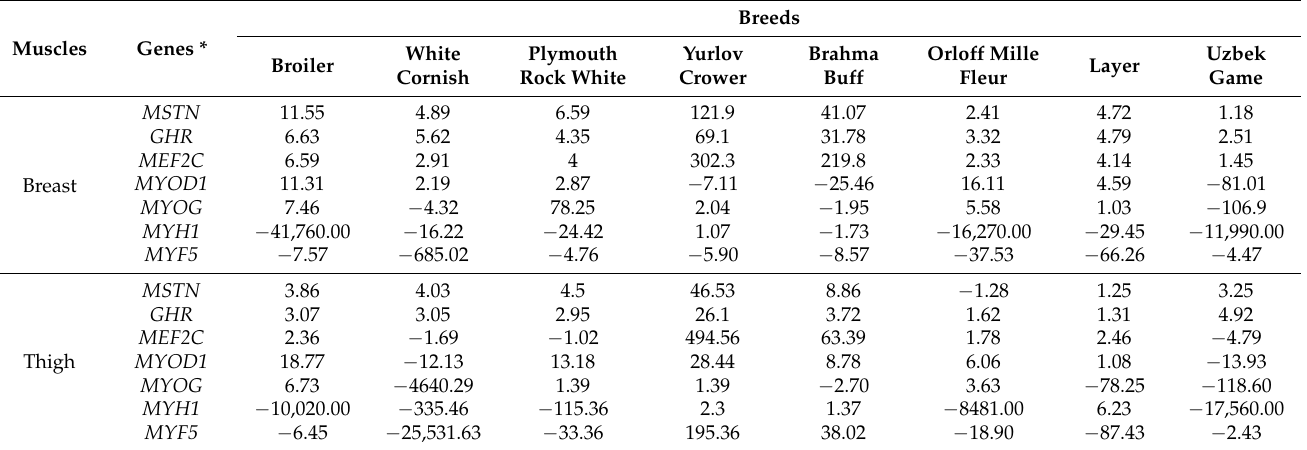
Table 2. Relative gene expression levels defined by FC values in the breast and thigh muscles of E14 chick embryos as estimated in the studied